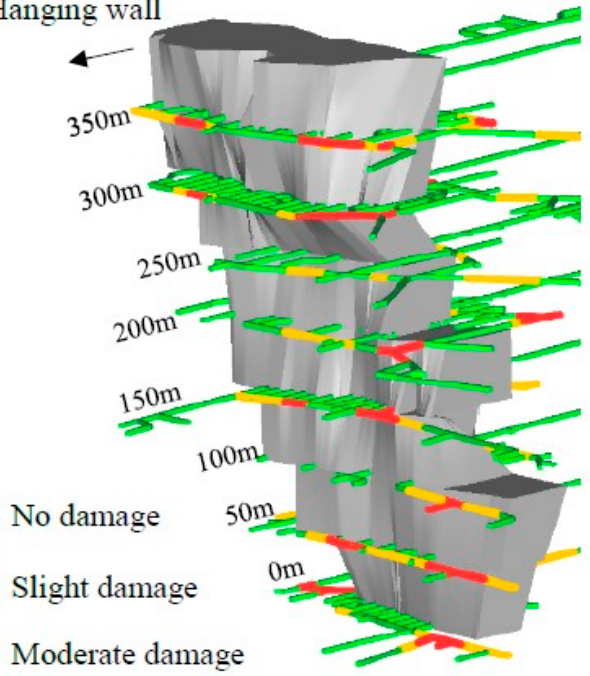
Figure 4. Distribution of tunnel damage with different damage in the Ashele Copper Mine.